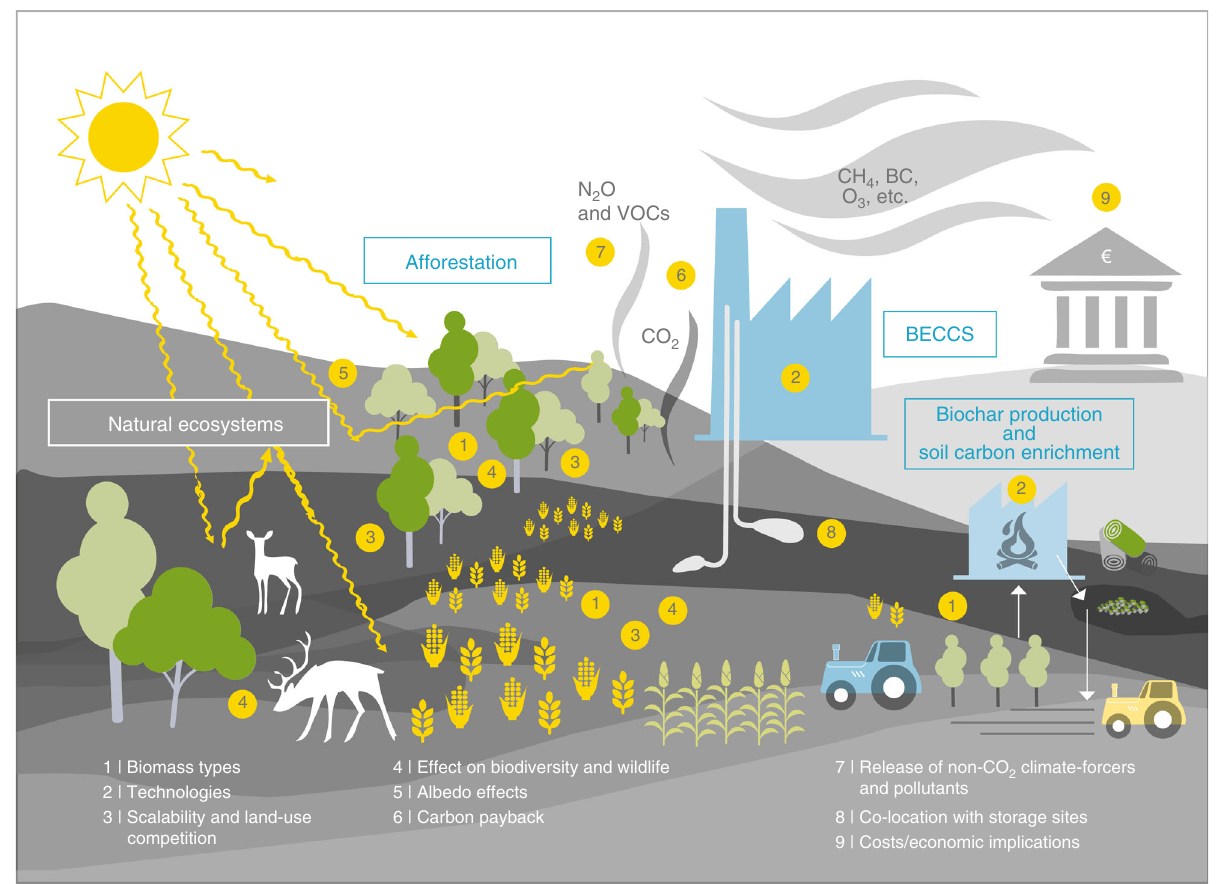
Fig. 3 Schematic of research needs for proposed biomass-based CDR techniques. A broad range of issues would need to be clari fi ed to better understand the removal potentials, costs, trade-offs and risks prior to a possible implementation of any biomass-based CDR technique, as detailed in two